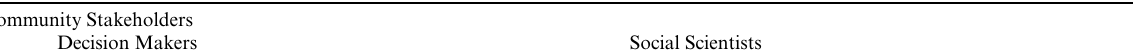
Table 1 . Criteria used for ranking human well-being indicators by different